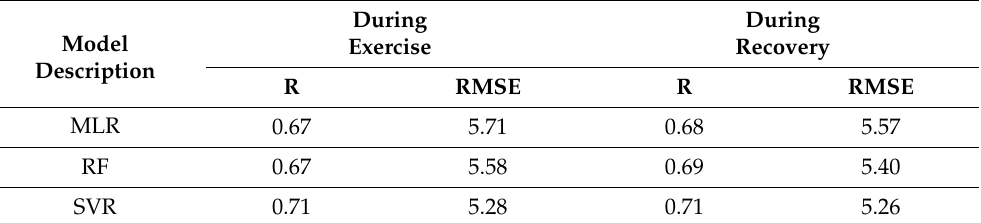
Table 5. Performance Metrics of models with all the features.